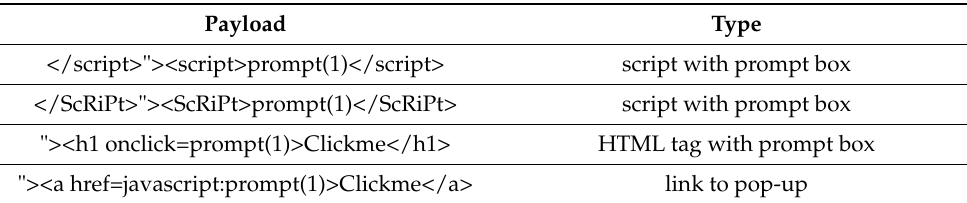
Table 1. Payloads used in the